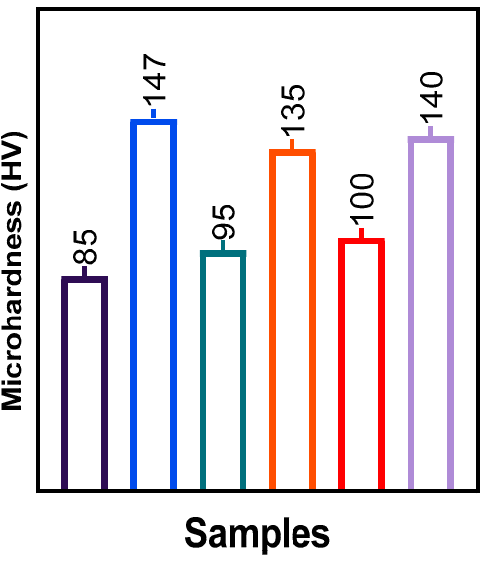
Figure 10. The hardness of the samples.